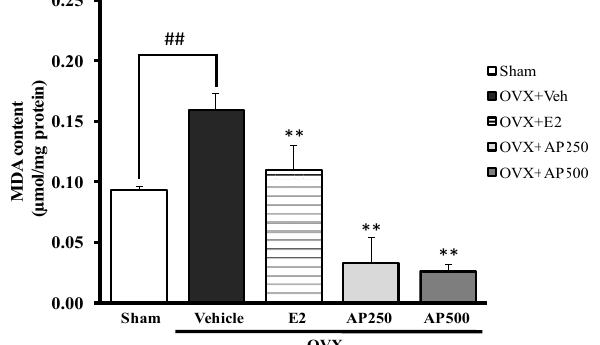
Figure 3. Effect of the AP extract on the OVX-induced oxidative damage in mice whole brain. Values given were the mean ± SEM (n = 6). Significant ANOVA effects were represented by ## p < 0.001 vs. the sham-operated group and ** p < 0.001 vs. the OVX group (post hoc Tukey